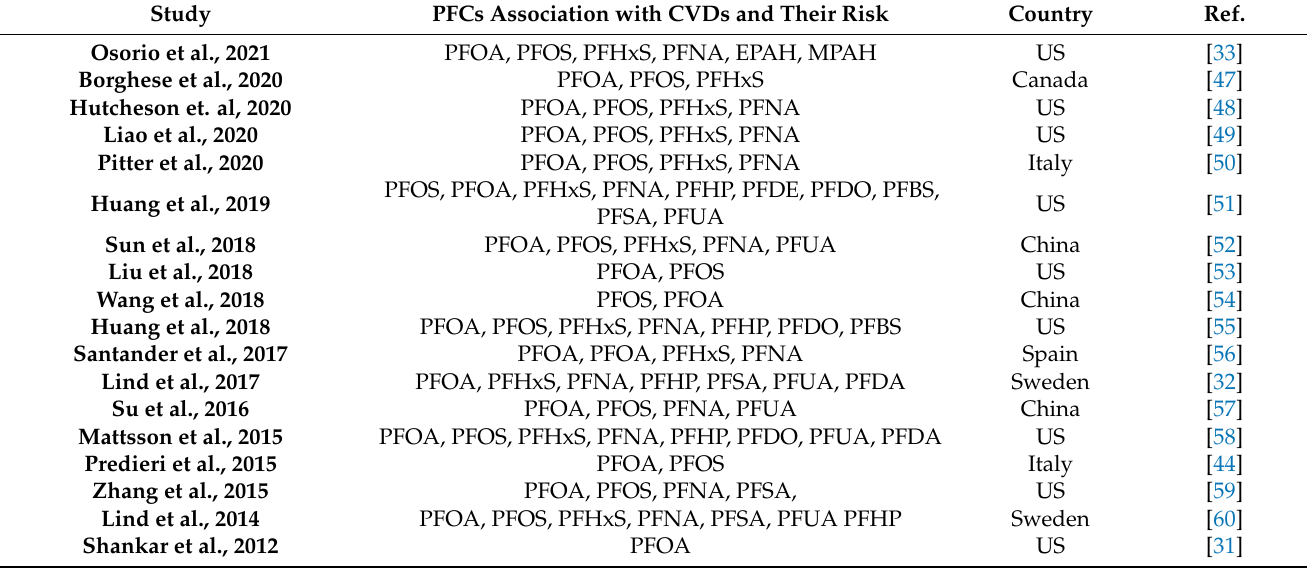
Table 1. Summary of PFCs exposure association with CVDs and their